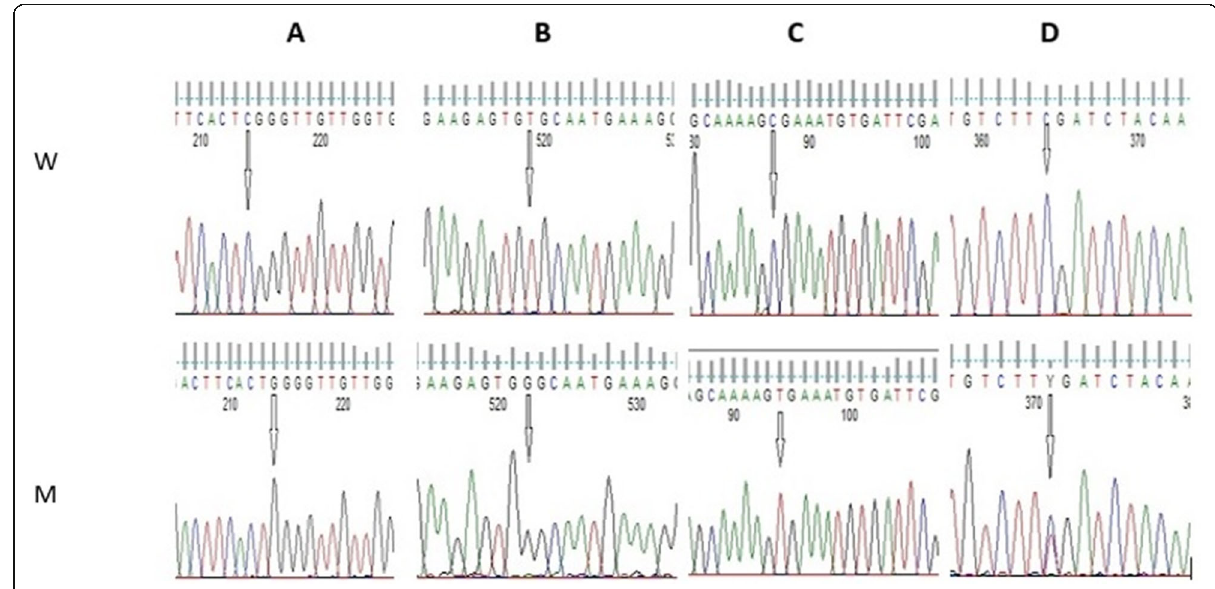
Fig. 1 Partial nucleotide sequence of F9 gene. a Missense mutation c.676C>G in exon 6 identified in patients no. 1 and 2. b Missense mutation c.1305T>G in exon 8 identified in patient no. 3. c Nonsense mutation c.880C>T in exon 8 identified in families no. 4, 5, 6. d Nonsense mutation c.1150C>T in exon 8 identified in carrier mother family no. 7 (W for wild and M for